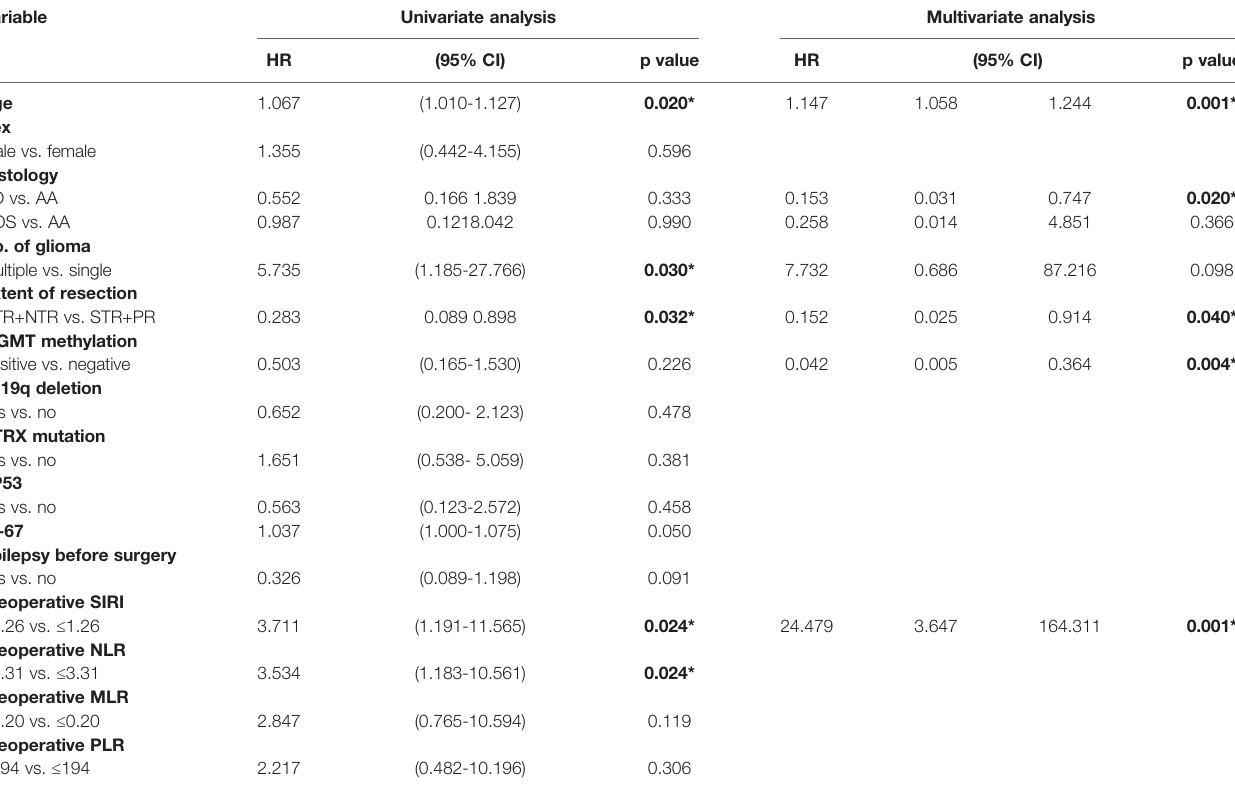
TABLE 6 | Univariate and multivariate cox regression analyses for overall survival in IDH mutant-type grade III glioma subgroup.